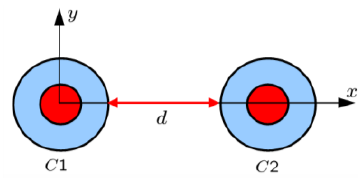
R |log10RR  [dB] as a function of frequency for Figure 4. ( a ) and ( b ): The quantity | t 10 the resonant 2-cylinder structures for different separation distances d . The magnitude of the electric field of the resonant 2-cylinder structures for 40  d mm and 250  f MHz; d   . ( c ) and 300  f MHz ( d ). In all cases, the ELC is located at )0,2/(),( o 1, Coss The electric field in (c) and (d) is depicted in the xy -plane and the linear dynamic range (DR) in V/m is indicated below the figures. Curves representing the circular surfaces of the structure and a left-right arrow, indicating the size scale of the figure, are likewise shown in (c) and (d). Inset above the figure shows the 2-cylinder structure consisting of cylinders C 1 and C